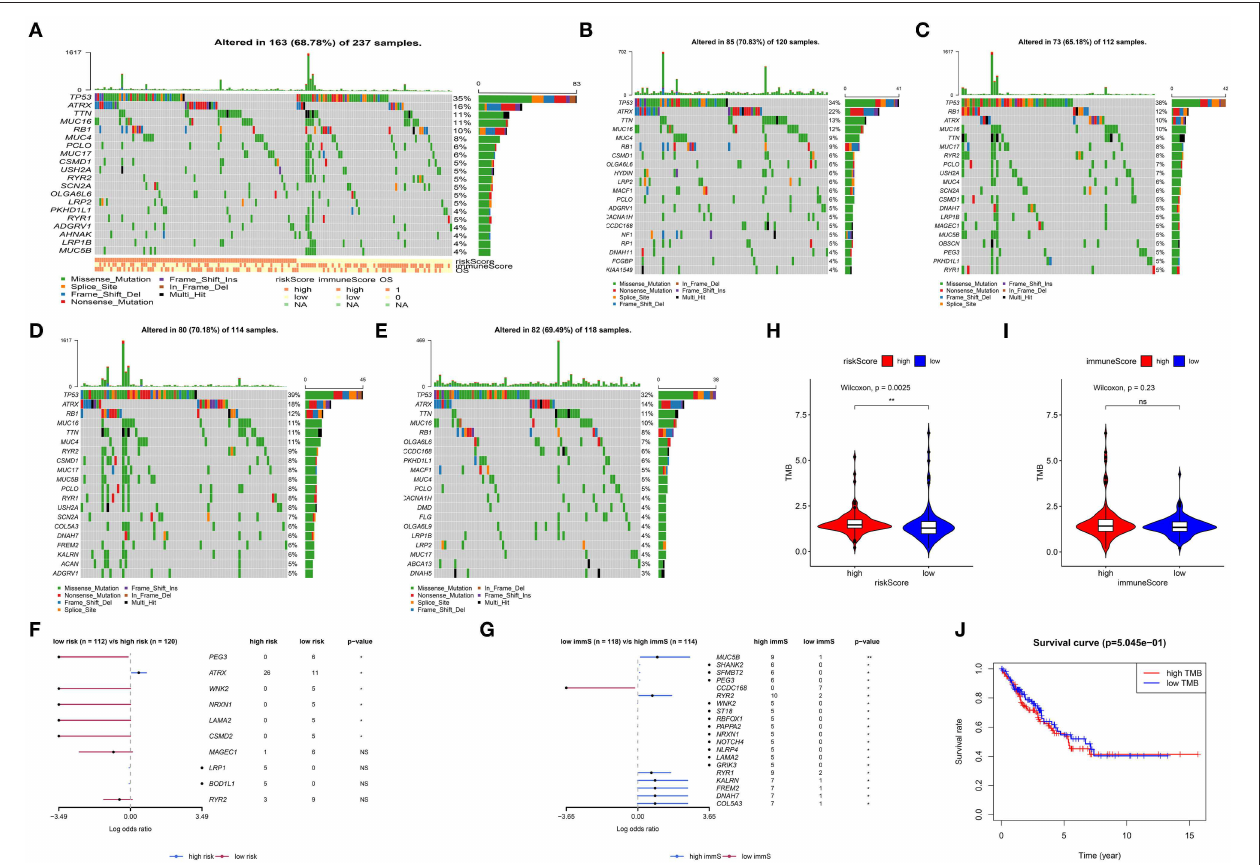
FIGURE 6 | Analysis of somatic variants in soft tissue sarcoma (STS). Top 20 gene mutations in all patients (A) . Top 20 gene mutations in high- (B) and low-risk patients (C) . Top 20 gene mutations in patients with high (D) and low (E) immune scores. Comparison of high- with low-risk patients (F) , as well as patients with high and low immune scores (G) . (H) Comparison of the log(TMB + 1) in high- and low-risk patients. (I) Comparison of the log(TMB + 1) in patients with high and low immune scores. (J) Survival curve for patients with high and low TMB. TMB, tumor mutation burden. **0.001 < p < 0.01; *0.01 < p < 0.05; ns (not significant), p >